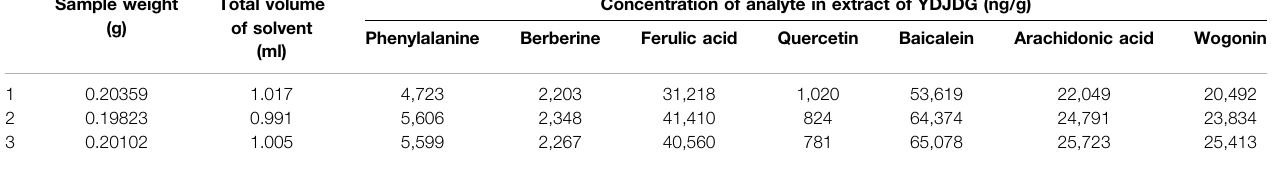
TABLE 6 | The contents of seven compounds in the YDJDG. Sample weight